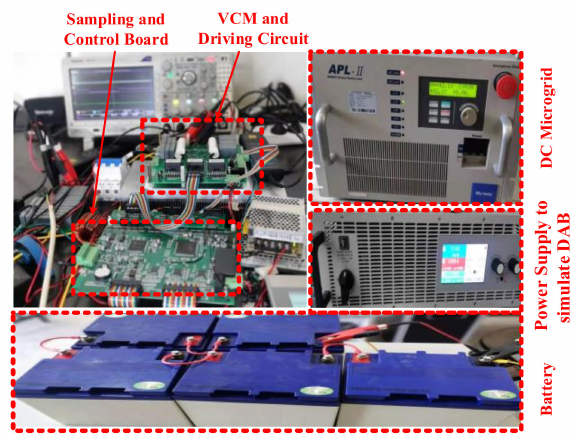
Figure 12. Physical experiment